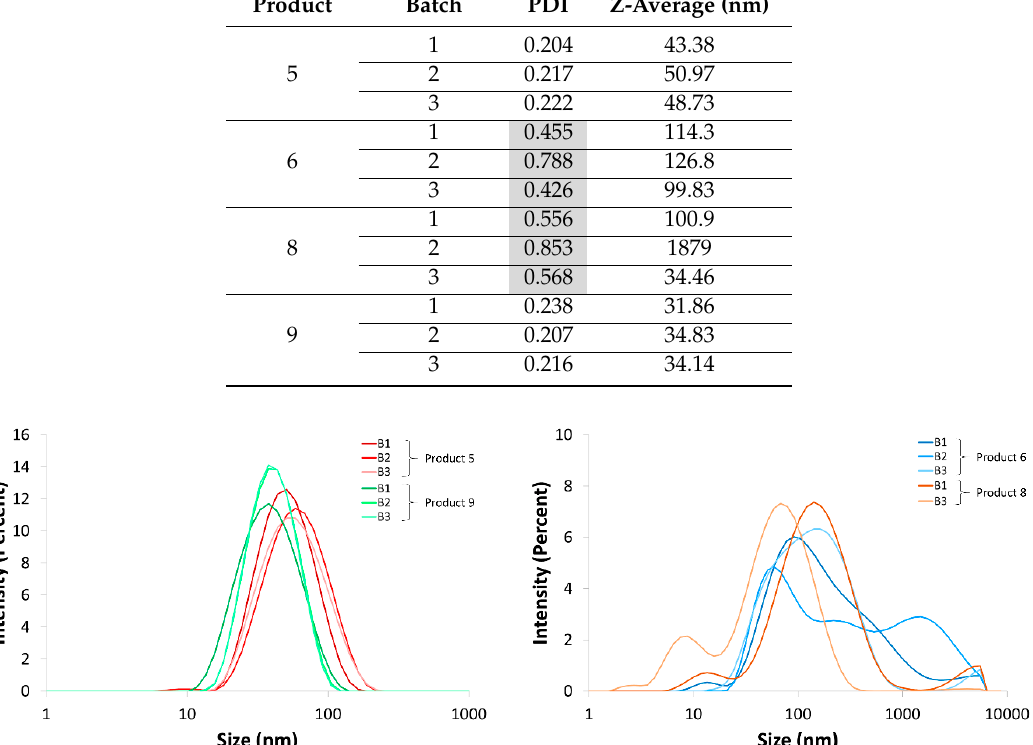
Table 5. Polydispersity index (PDI) and Z-average of the three di ff erent batches of products 5, 6, 8, and 9. PDI values > 0.400 are indicated in grayscale.